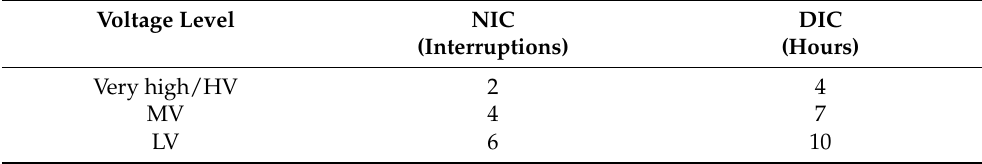
Table 10. Tolerance limits for indicators in Peru for urban areas.